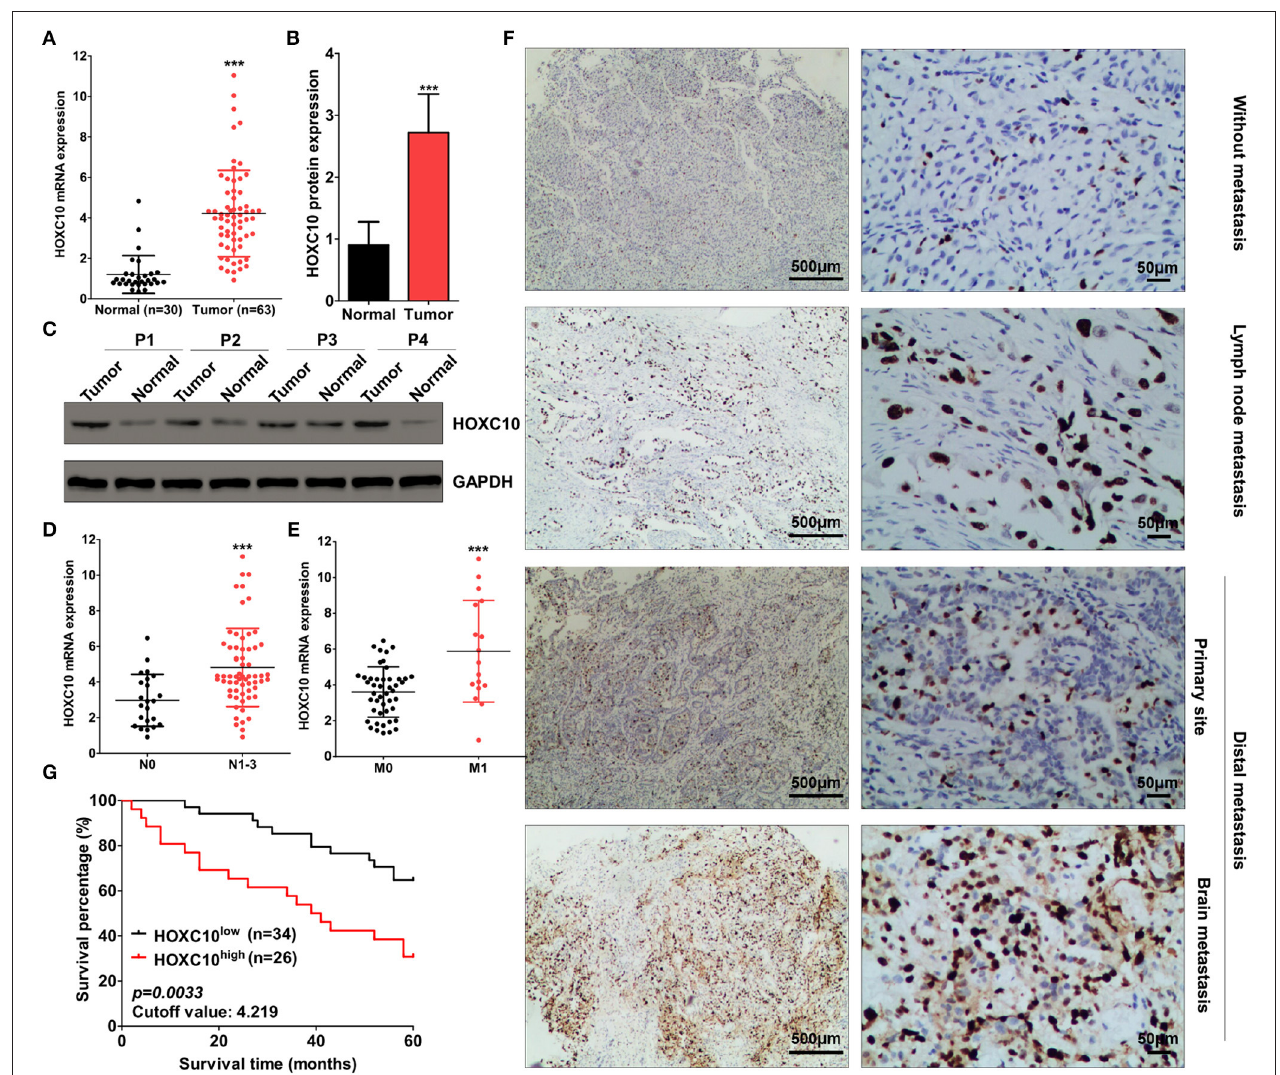
FIGURE 1 | HOXC10 upregulates in human lung cancer tissues. (A) Relative mRNA expression of HOXC10 in human lung cancer ( n = 63) and normal ( n = 30) tissues was detected by qRT-PCR, GAPDH was used as internal control. (B) Protein expression of HOXC10 in tissues from four represent patients was detected by western blotting; and relative HOXC10 expression was normalized to housekeeping gene GAPDH (C) . (D,E) Data was derived from (A) , patients were subdivided into two groups according to lymph node (D , N0 and N1-3) or distal metastasis (E , M0 and M1), relative mRNA expression of HOXC10 was compared between these two groups, respectively. (F) The protein expression of HOXC10 in lung cancer tissues with or without metastasis was evaluated by immunohistochemistry. (G) Patients were subdivided into two groups according to the mean value of HOXC10 mRNA expression (cutoff value: 4.219), and survival analysis carried out by the Kaplan-Meier method, and subjected to the log rank test. Data are presented as means ± SD , *** p <